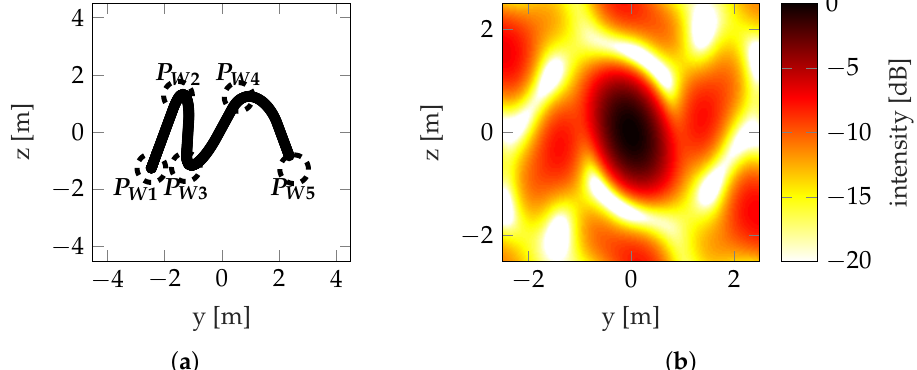
Figure 15. Worst final situation—run #8: ( a ) Trajectory with waypoints denoted by P W and the acceptance circles marked with a dotted line. ( b )